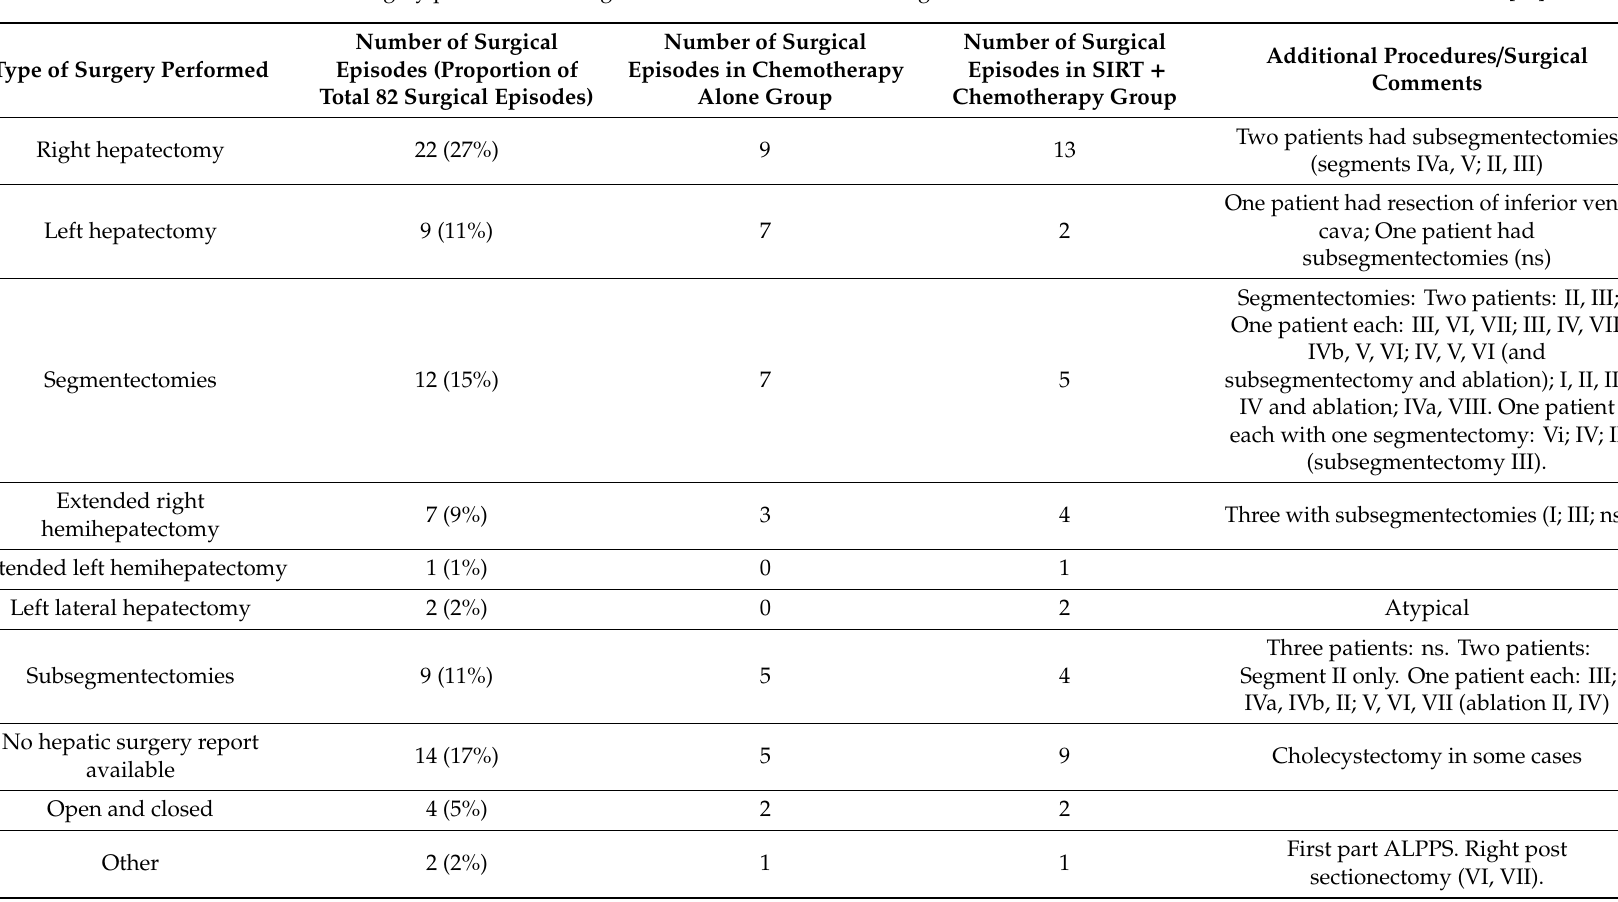
Table 2. Classification of liver surgery performed during the FOXFIRE clinical trial. Surgical classification based on the Brisbane 2000 classification [12].